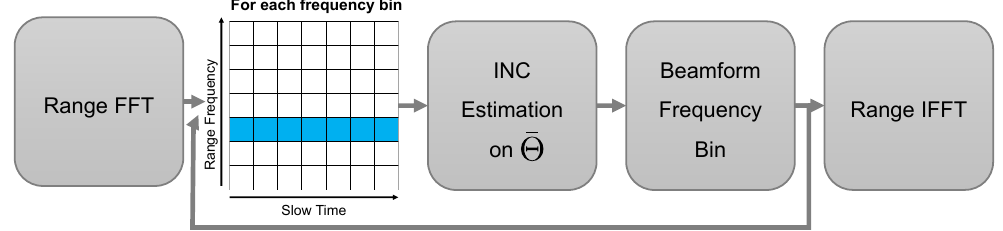
Figure 6. Segment-Wise Frequency MVDR RFI mitigation with Digital Beamforming (DBF). A mitigation of N − 1 interferers per frequency bin is